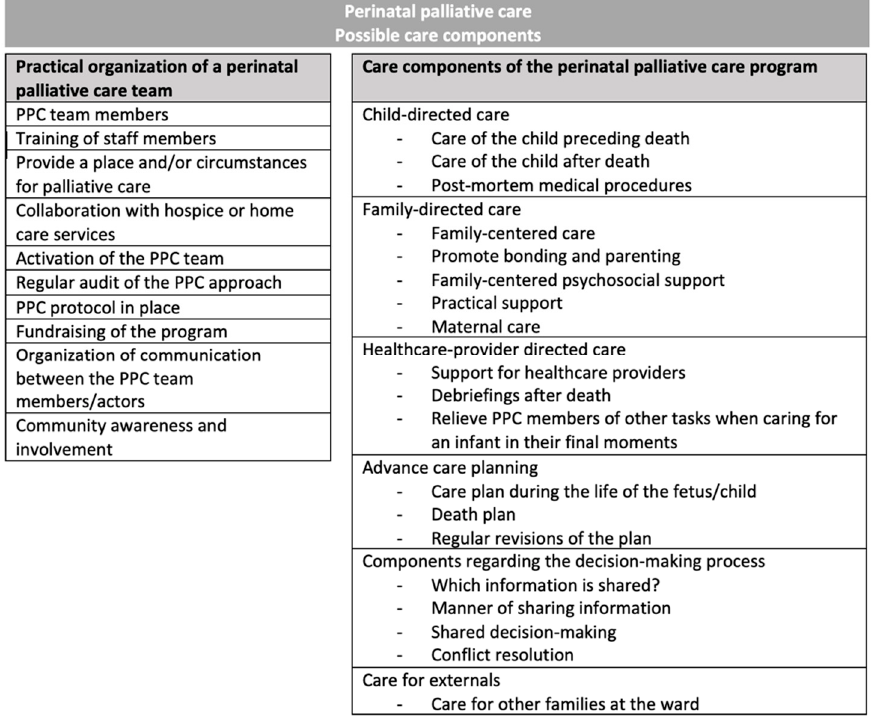
Figure 2. Schematic overview of all involved (care) components in PPC programs (summary, for more information, see detailed Table 5). Table 5. Overview of all involved (care) components in PPC